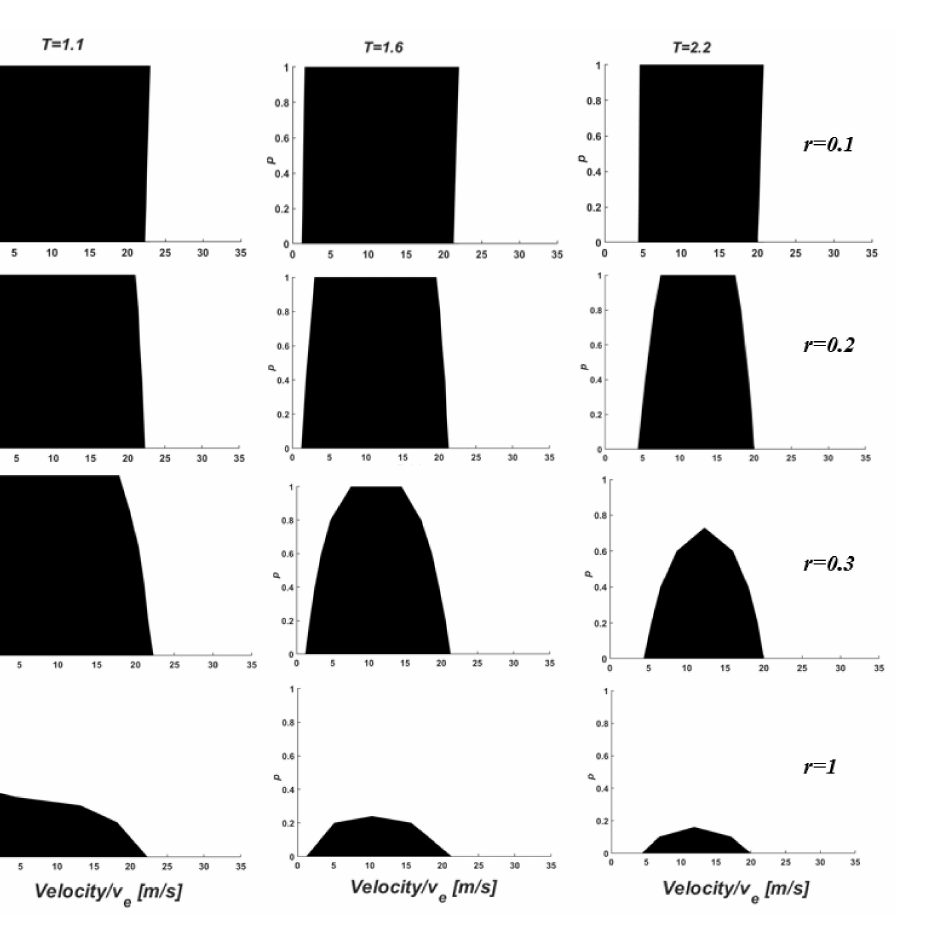
Figure 8. Stability region of heterogeneous traffic